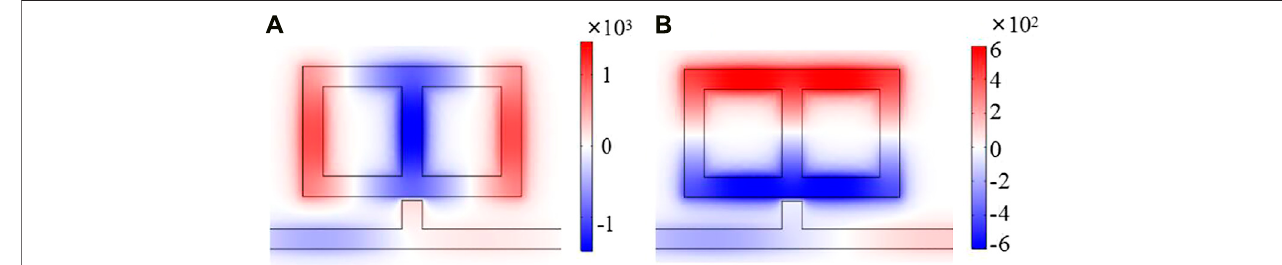
Frontiers in Physics |